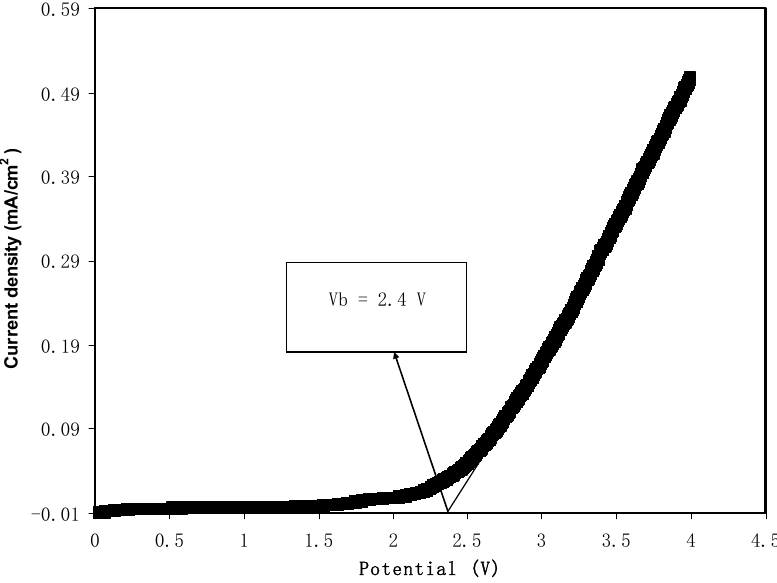
Figure 6. Linear sweep voltammetry (LSV) curve of the prepared polymer electrolyte system.